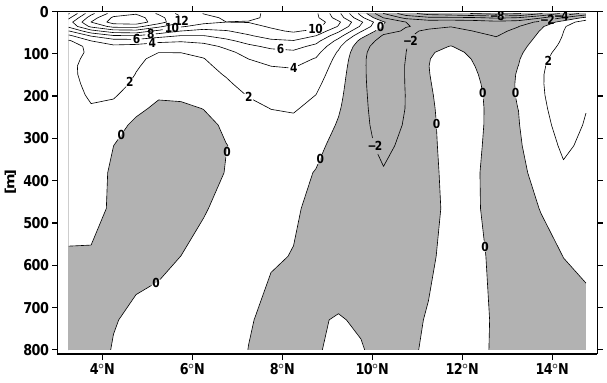
Figure 3. SODA model mean velocity section in cms − 1 for the pe- riod 2001–2010 along 23 ◦ W (positive eastward).